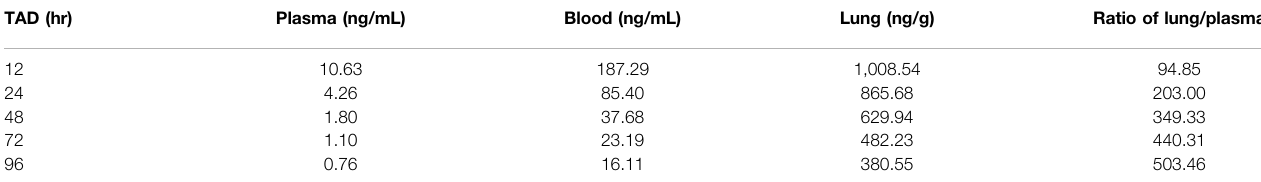
TABLE 5 | Simulated HCQ concentration data in the plasma, blood and lung, and the ratio of lung/plasma based on the fi nal population PK model. TAD